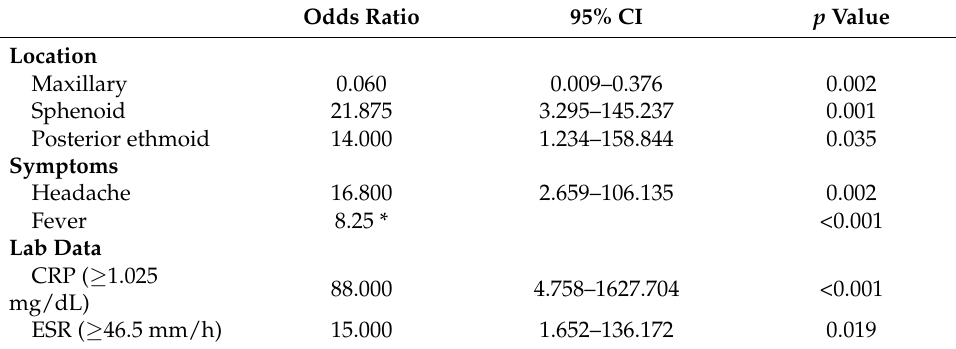
Table 3. The clinical signs associated with